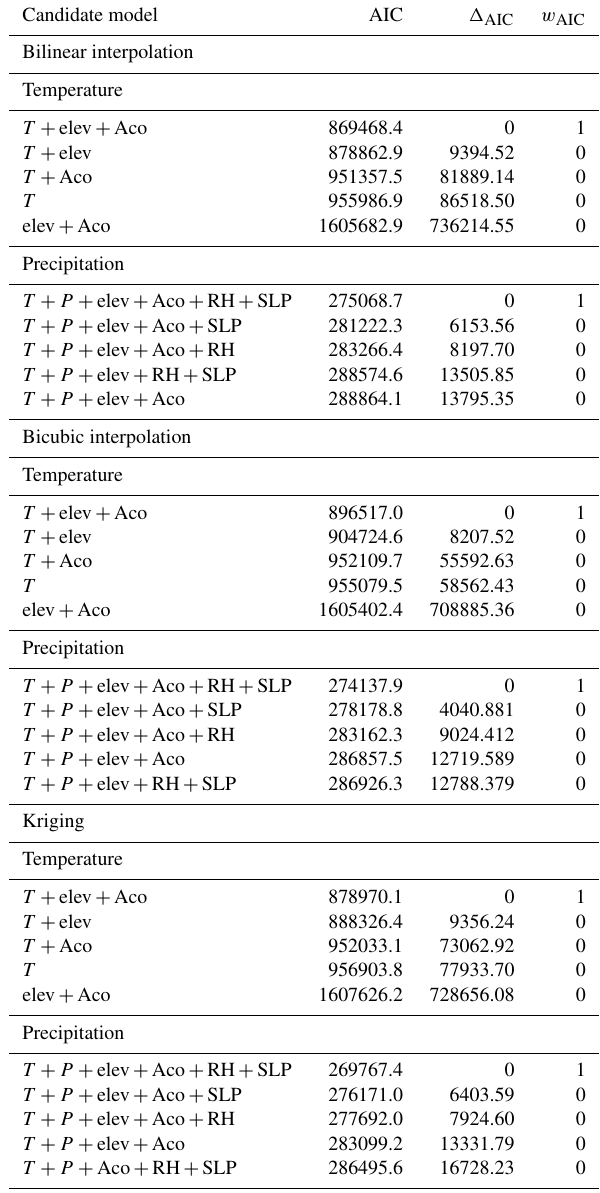
Table 1. Model selection among all possible combinations of vari- ables for the temperature and the precipitation. Only the five mod- els with the lowest AIC are presented. AIC scores, differences in AIC compared to the lowest scoring model ( (cid:49) AIC ) and AIC weights ( w AIC = exp( − 0 . 5 × (cid:49) AIC ) ∈ [ 0 , 1 ] , representing the relative like- lihood of the models) are reported.